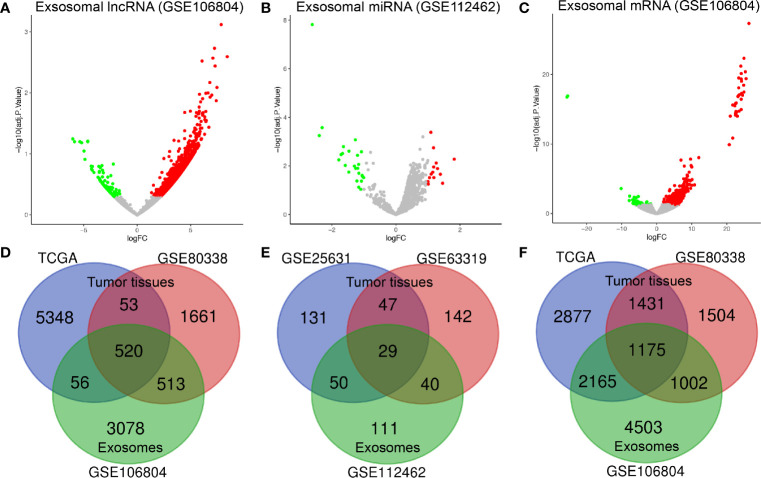
Identification of differentially expressed exosome-related genes. Volcano plots of (A) DElncRNAs, (B) DEmiRNAs, and (C) DEmRNAs between GBM serum exosomes and normal samples. The red dots represent upregulated genes, and the green dots represent downregulated genes. The Venn diagram shows (D) 520 DElncRNAs, (E) 29 DEmiRNAs, and (F) 1175 DEmRNAs in the overlapping part of exosome-related DE-RNAs and GBM tissue-related DE-RNAs. adj. P value: adjusted P value; FC: fold change.